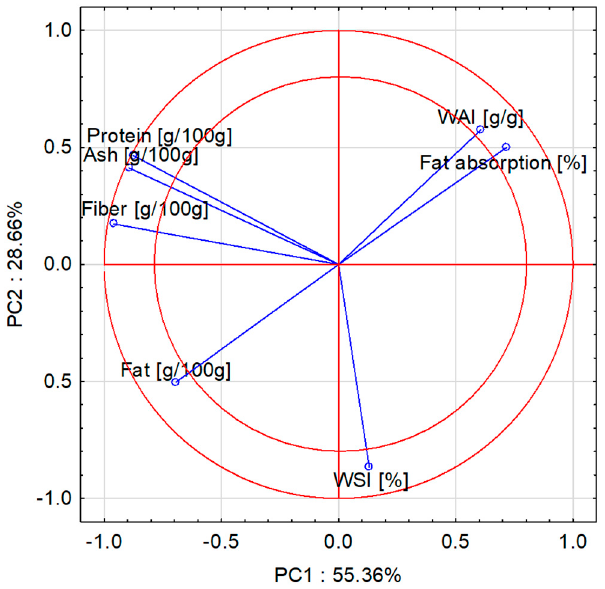
Figure 1. PC1 and PC2 score plot. Projection of variables: fiber, protein, ash, fat, WAI, WSI, and fat absorption index.